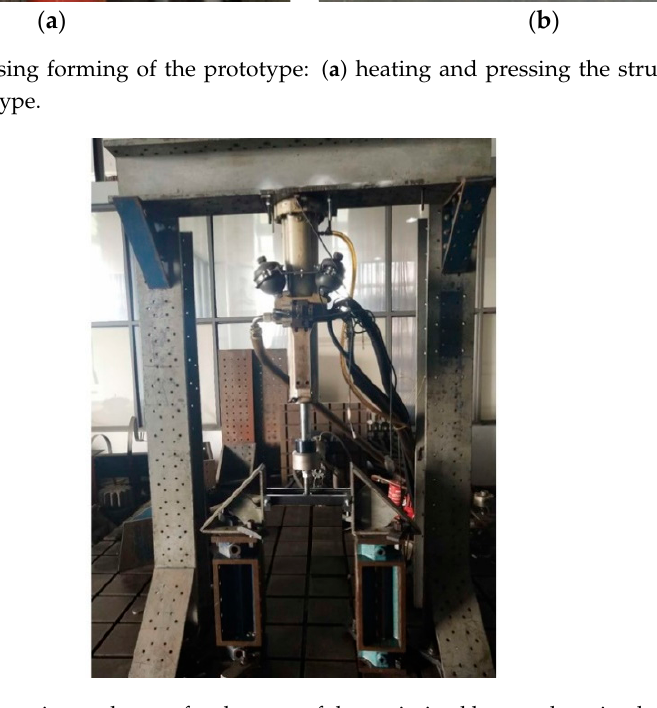
Figure 9. Experimental setup for the tests of the optimized battery-hanging beam.